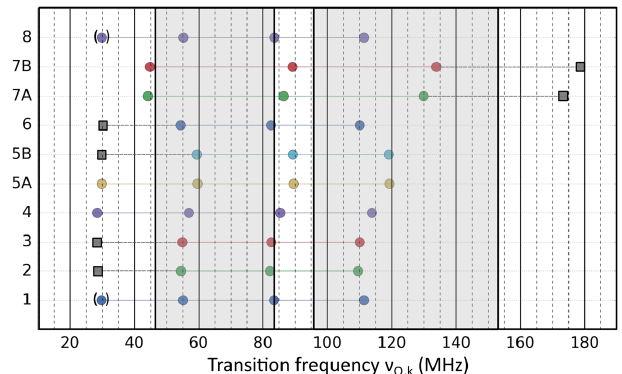
FIG. 4. NQR frequencies of samples 1 – 8. The pure NQR target frequency to create a QRE peak accessible for a FFC-MRI scanner with a B 0 shift of 1 . 5 T (cid:2) 200 mT and 2 . 89 T (cid:2) 200 mT is marked in grey. This frequency range can be calculated using the resonance condition Eq. (1) and the transition frequency spectrum as in Appendix A, Eq. (A7) [also compare to Fig. 2(b)]. Colored circles have been measured; grey squares mark calcu- lated values [from Eq. (A7) in Appendix A]. Dots in brackets are measurements at RT; the rest have been obtained at 37 °C.